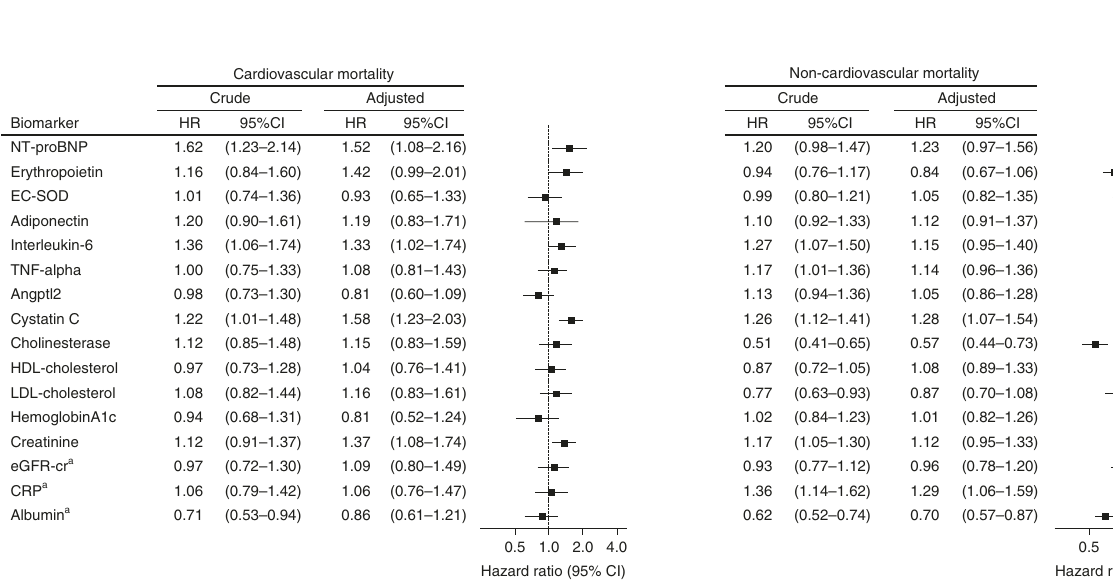
Fig. 7 Hazard ratios for cardiovascular and non-cardiovascular mortality in the very old according to circulating biomarkers. Data on cause-speci fi c mortality were available for the very old, aged 85 – 99 years; 48 died from cardiovascular disease, 41 from cancers, 36 from pneumonia, 5 from advanced dementia, 34 from other causes, and 27 from unknown causes. Those who died from unknown causes were censored in the analysis. Hazard ratios (HRs) and 95% con fi dence intervals (CIs) for cardiovascular and non-cardiovascular mortality were calculated with the use of univariate and multivariate Cox regression hazard models. Multivariate analyses were adjusted for base model covariates; sex, age, educational status, current smoking, history